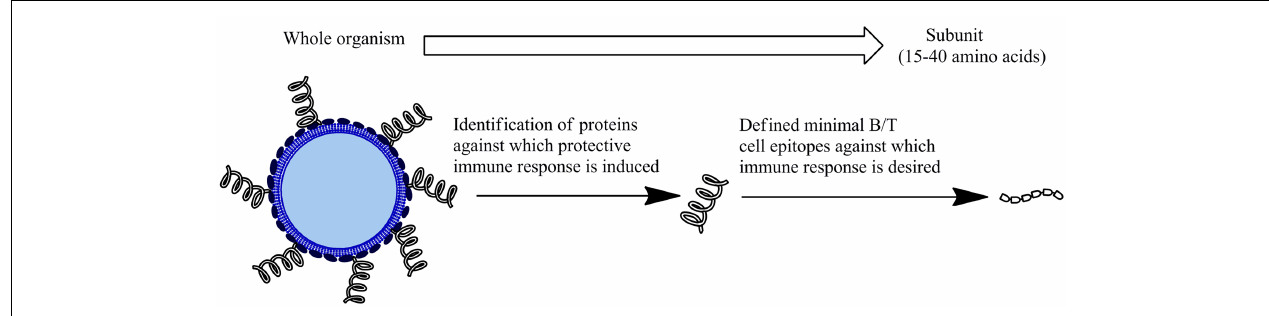
FIGURE 1 | Subunit vaccines . An alternative to inactivated or attenuated whole pathogen vaccines. Comprised of fragment/s of the microorganism to generate a protective immune response.